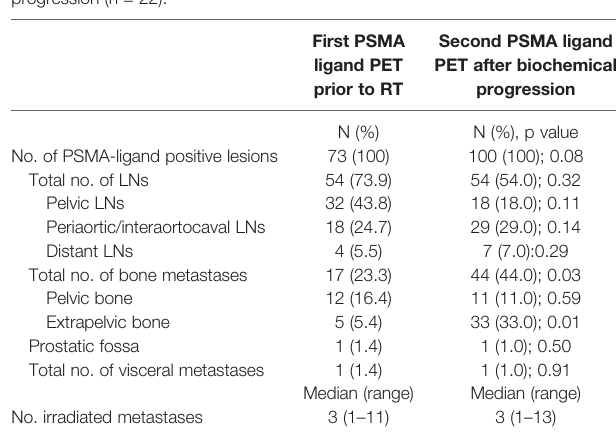
TABLE 2 | Results of fi rst PSMA ligand PET staging prior to PSMA PET-guided radiotherapy and second PSMA ligand PET for restaging after biochemical progression (n =